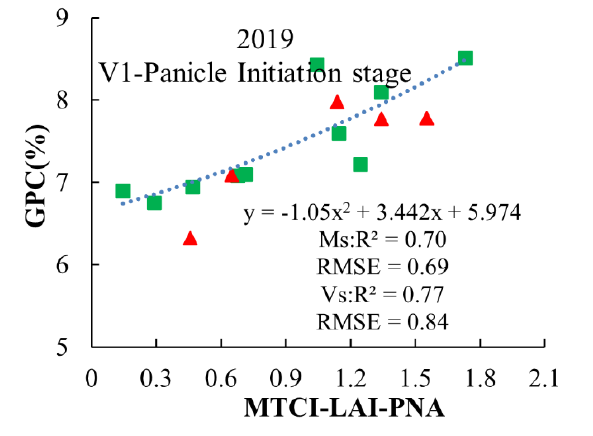
Figure 14. Monitoring maps for rice variety V1 (Meixiangzhan 2) in the panicle initiation stage in 2019 for the study area: ( a ) MERIS terrestrial chlorophyll index (MTCI), ( b ) leaf area index (LAI), and ( c ) plant nitrogen accumulation (PNA).